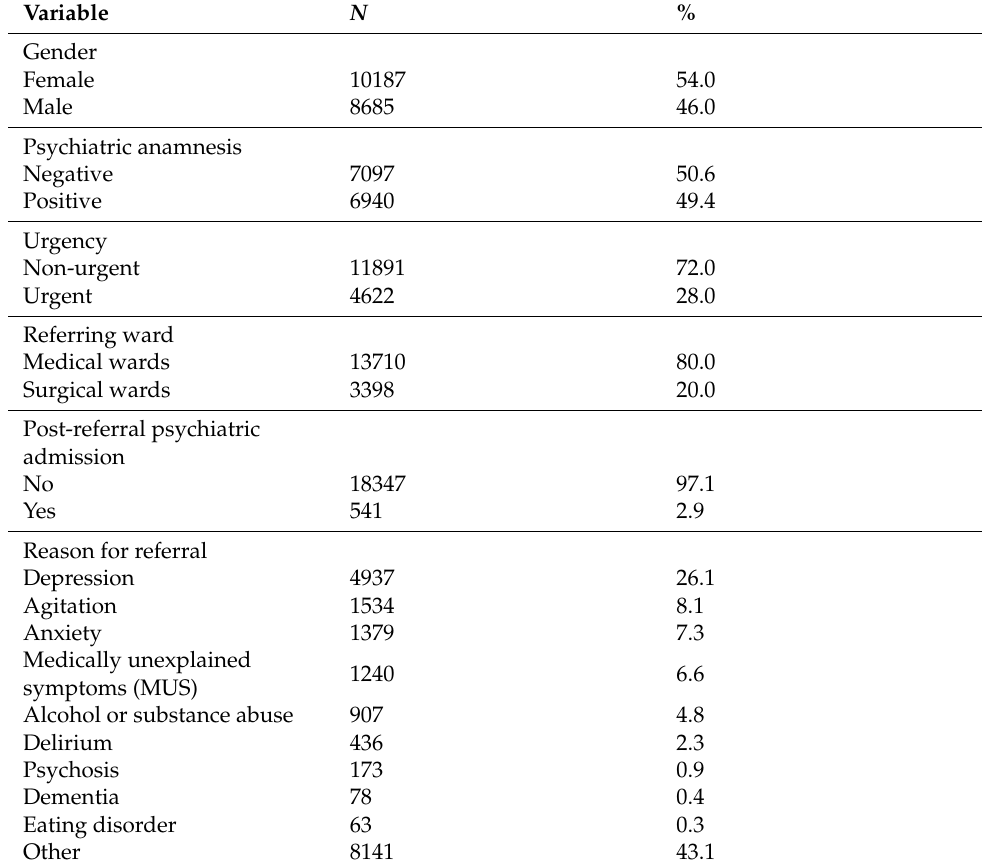
Table 1. Details of